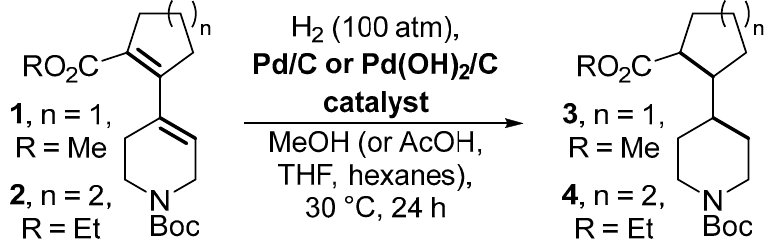
Figure 10. Scheme of the catalytic hydrogenation of N -Boc protected 5,6-dihydro-pyridine-1(2 H )-carboxylates 1 and 2 bearing additional 2-(alkoxycarbonyl)-cyclopent-1-en-1-yl and hex-1-en-1-yl substituents at C(4)-position, respectively.